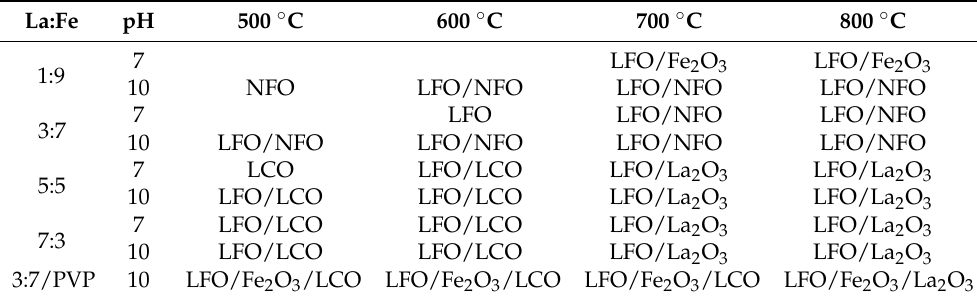
Figure 1. Scheme of the synthesis route. Table 1. Phases of products prepared by NaOH precipitation; NFO and LCO represent NaFeO 2 and La 2 O 2 CO 3 ,